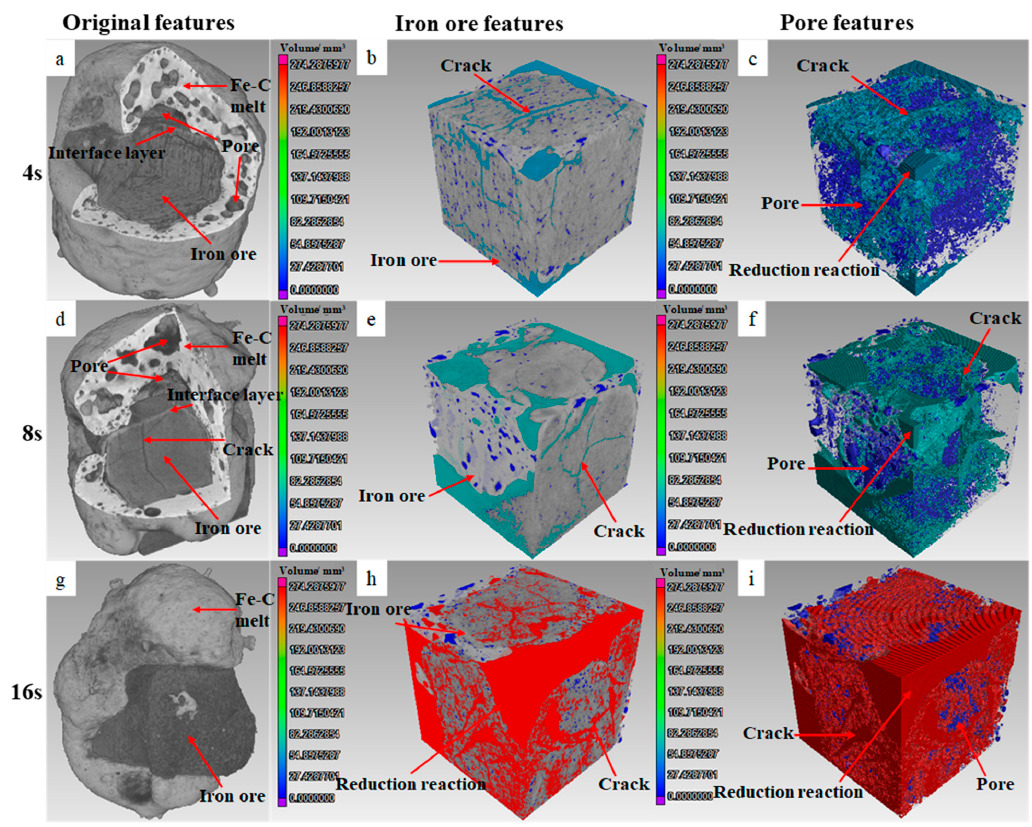
Figure 10. Crack morphology structure evolution of #2 at different smelting reduction moments.